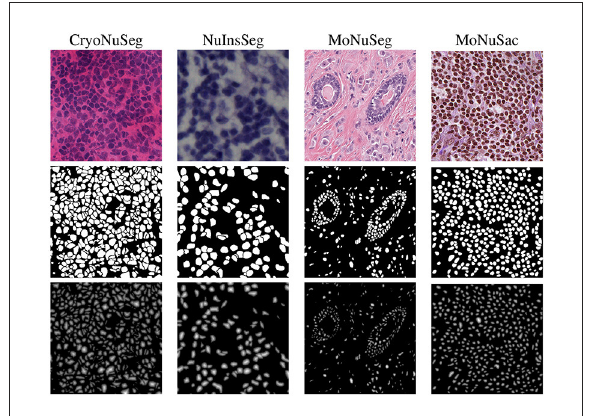
FIGURE2 Image examples from the employed datasets (first row), the refined masks generated from ground truth annotations (second row), and the obtained distance maps (third